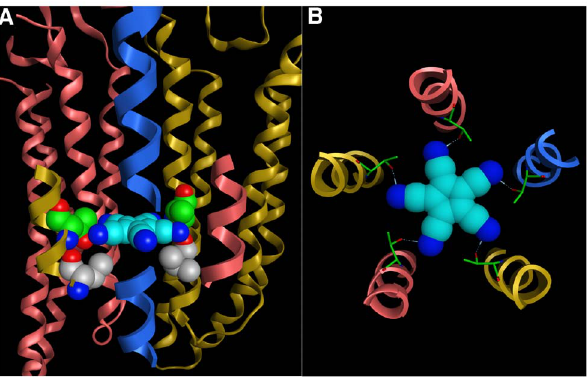
Figure 12. Molecular model of the interaction of PCCP 2 with GABA A receptors. A, The side view of the PCCP 2 docking pose from the perspective of the c 2 subunit. The ligand and the mutated residues of the a 1 subunit, which have an impact on the affinity of the ligand, are shown in space filling representation. The 2 9 valines of the a 1 subunit are rendered grey; the 6 9 threonines of the a 1 subunit in green. The GABA A receptor is displayed in ribbon representation with a 1 subunits shown in yellow, b 2 subunits in red, c 2 subunit in blue. The complete transmembrane domain (TMD) is shown only of the a 1 and the b 2 subunits in the back. Of the subunits in front, only a segment of the transmembrane domain 2 (TMD2) is depicted. The TMD2 of the c 2 subunit is only partly displayed to provide a ‘‘window’’ through which the ligand is seen. B, Top view of the pose showing the symmetric molecular interactions between ligand and receptor. PCCP 2 (space filling) forms H-bonds (blue dashed lines) to the –OH groups of the 6 9 threonines (stick representation) of each of the five